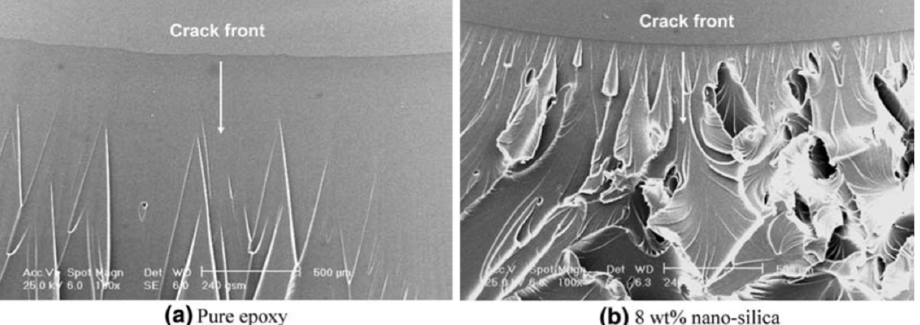
Figure 13. SEM micrographs of fracture surfaces near crack tips ( a ) pure epoxy, and ( b ) 8 wt % nano-silica [84] .